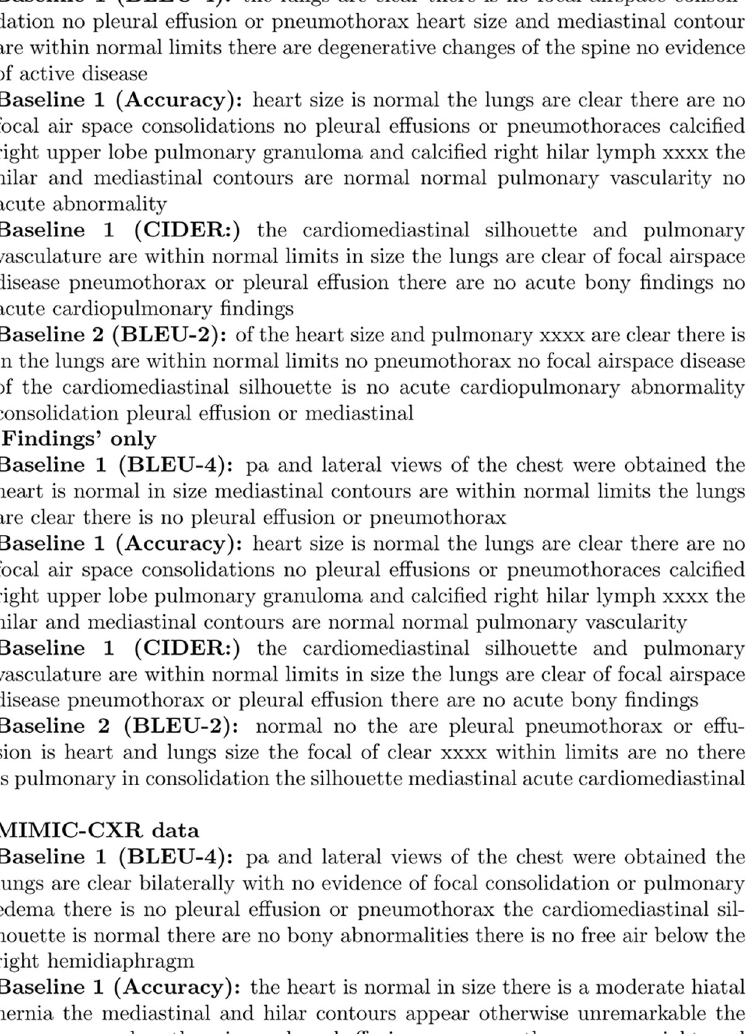
Fig 5. Typical reports generated by Baseline 1 and 2 (over one train/test